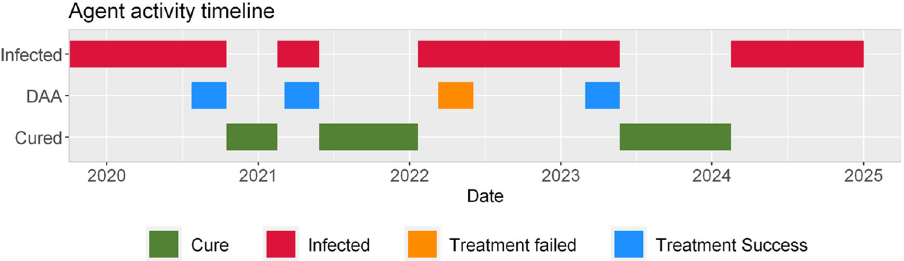
Fig 3. Activity timeline for a single agent in the HepCEP model who was allowed only four courses of DAA therapy. The colored bars indicate activities in which the agent is participating during the dates along the bottom of the timeline. The activity pattern shown in the figure are typical in some of HCV-positive agents that are selected for DAA treatment, cured, and re-infected multiple times. In this example, the agent was allowed to re-enroll in DAA treatment 3 times (total of 4 treatment courses), had a single occurrence of failed DAA treatment in year 2022 (orange bar) and eventually was re-infected ~1 year after SVR (in 2024) and remained chronically infected until 2030 (not